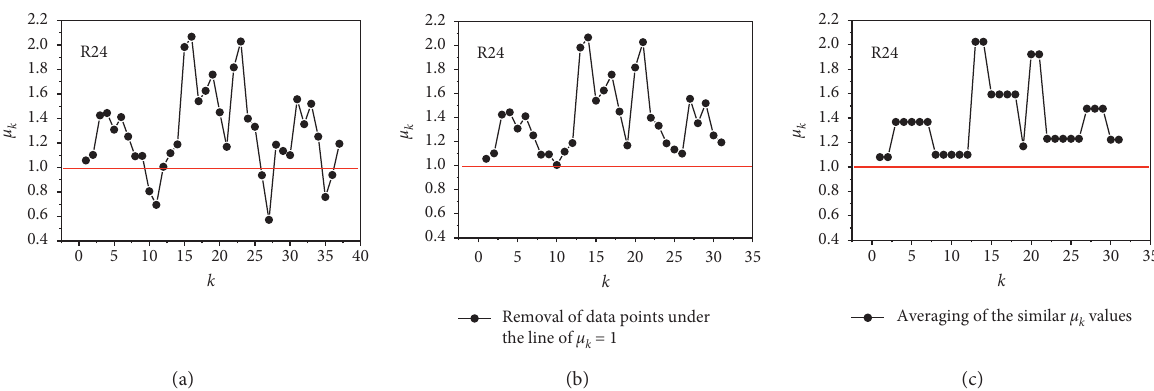
k of specimen R24.